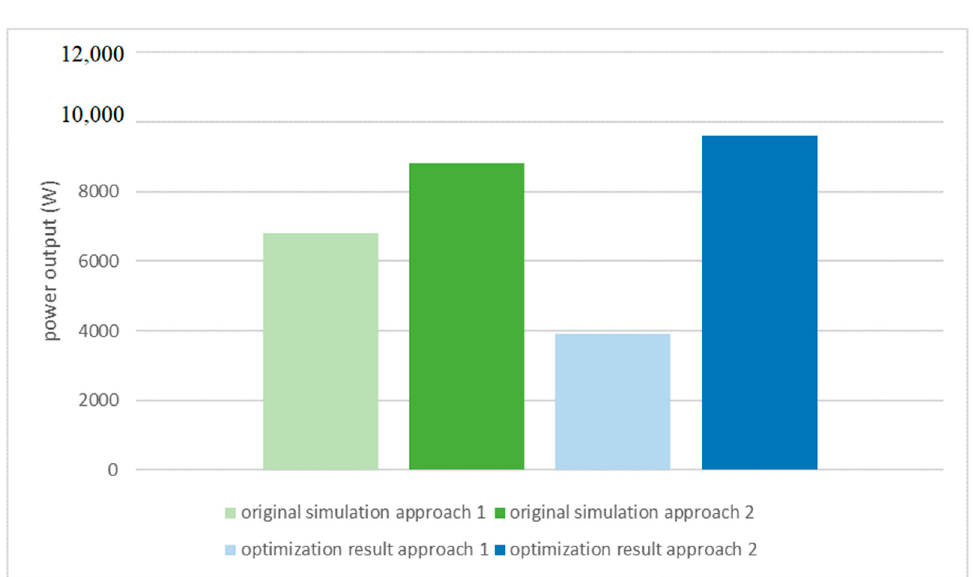
Figure 27. Comparison of two approaches in terms of power output.